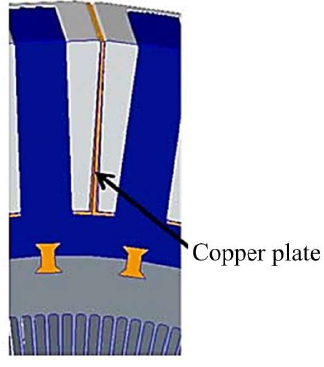
Figure 4. An aircraft wheel actuator with inserted T-shaped copper paths [27].